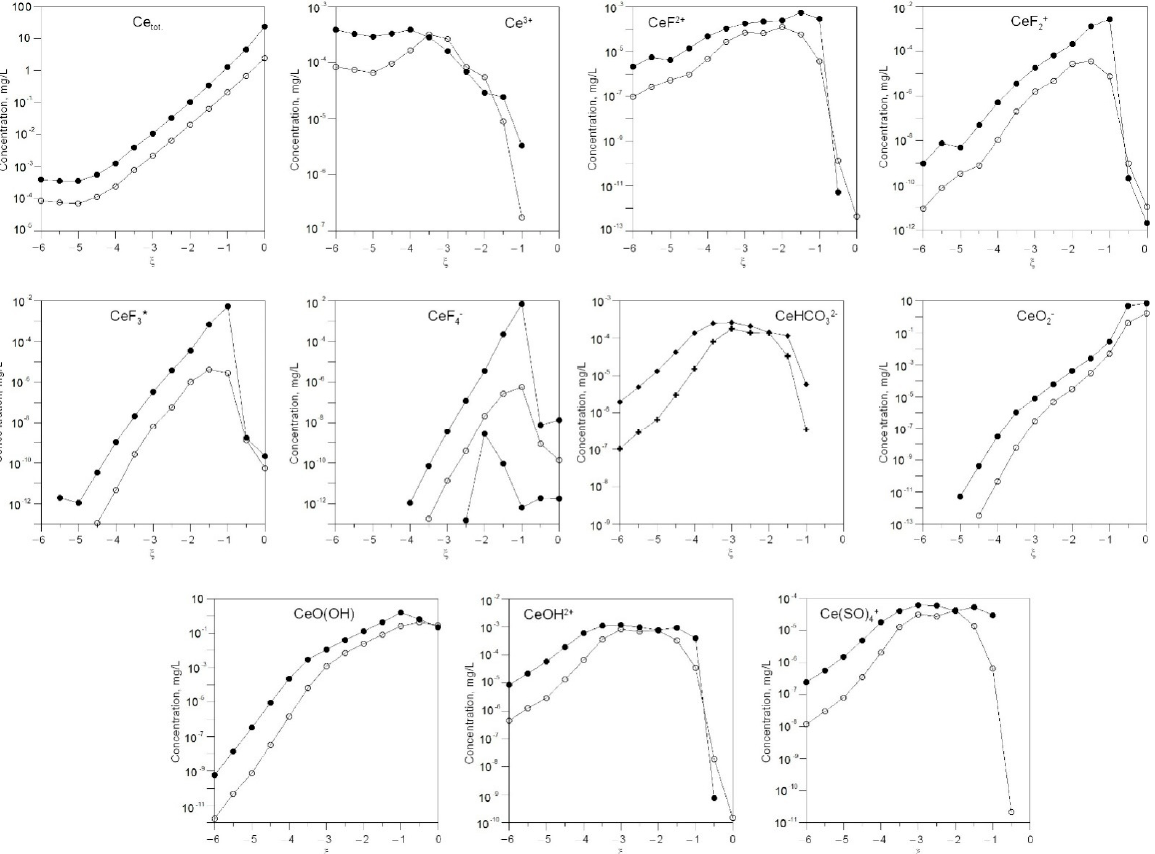
Figure 7. Change in the concentration of the dissolved forms of cerium in the solution depending on the degree of interaction ξ and 0.05 L (white) and 0.01 L (black) of water in the system. The main layered hydrosilicates are smectites and muscovite. Smectites forms at − 5.5 < ξ < − 2 and 0.05 L of water, and at − 6 < ξ < − 2.5 and 0.01 L of water. At low ξ , these are the main newly formed mineral phases in the system. Muscovite forms at − 4.5 < ξ < 0 and 0.05 L of water and at − 4 < ξ < − 0.5 and 0.01 L of water. The maximum content of this mineral is over 40%. Apatite forms at − 4 < ξ < − 1 and 0.05 L of water, and at − 3.5 < ξ < − 1 and 0.01 L of water. Higher contents of apatite are observed at 3 °C at high ξ . Silica forms at − 4 < ξ < − 1 and 0.05 L of water and at − 3.5 < ξ < − 1 at 20 °C. Calcite forms at − 3 < ξ < 0 and 0.05 L of water and at − 2.5 < ξ < − 0.5 and 0.01 L of wa- ter.Strontianite forms at − 4.5 < ξ < 0 and 0.05 L of water and at − 5 < ξ < − 0 and 0.01 L of water. In addition, at high ξ , other carbonates also formnatrite Na 2 CO 3 10H 2 O and trona Na 2 Ca (CO 3 ) 2 (H 2 O) 2 (not shown in Figure 8).